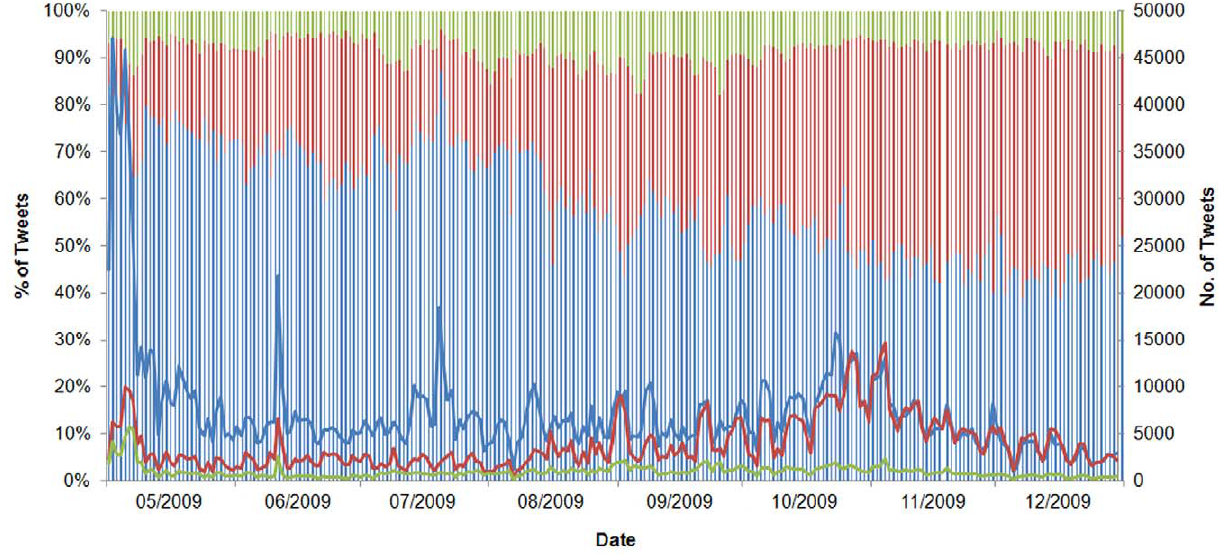
Figure 1. Tweets containing H1N1, swine flu, or both from May to December 2009. Lines=absolute number. Bars=relative percentage. Blue=‘‘swine flu’’ or swineflu. Red=H1N1. Green=(‘‘swine flu’’ or swineflu) AND H1N1.